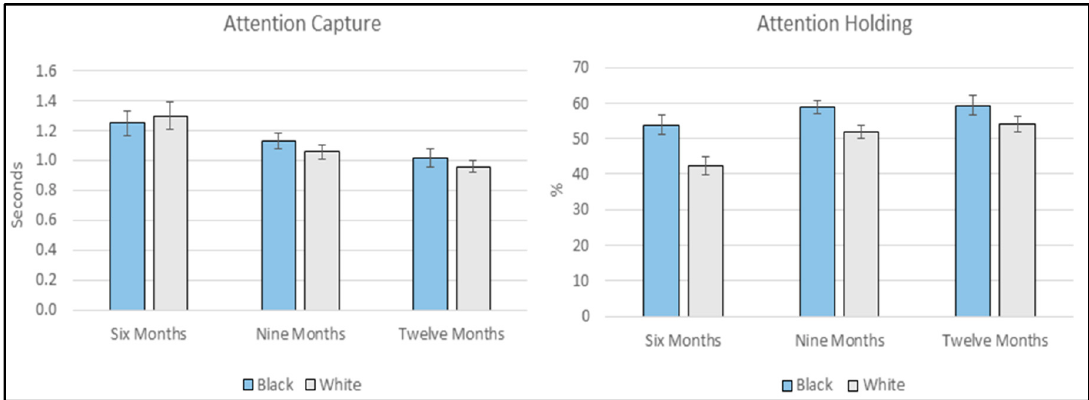
Figure 2. Face Fixation Onset Time ( Attention Capture ) and Post-First-Face Fixation Dwell Time ( Attention Holding ) for own- and other-race faces divided by age. Error bars are standard error of the mean.